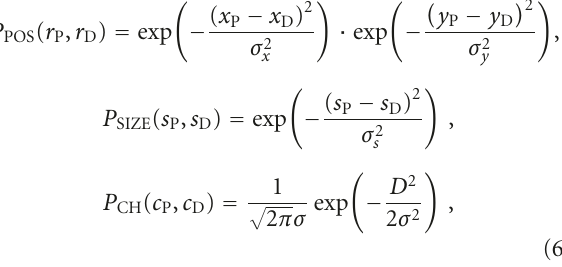
Figure 6: The origin of the two red lines has a ψ angle with degree m , corresponding to the red, m th, bin which contains two ( r , α ) pairs. Solid lines denote correct matches, while dashed lines represent noise. Di ff erent points on the head-shoulder contour in the edge image converge to a local maximum on the detection map on the right. At the bottom is the 180-bin reference table; a Gaussian weighting g is shown below the table, with the center bin labeled in red and the neighboring ten bins in